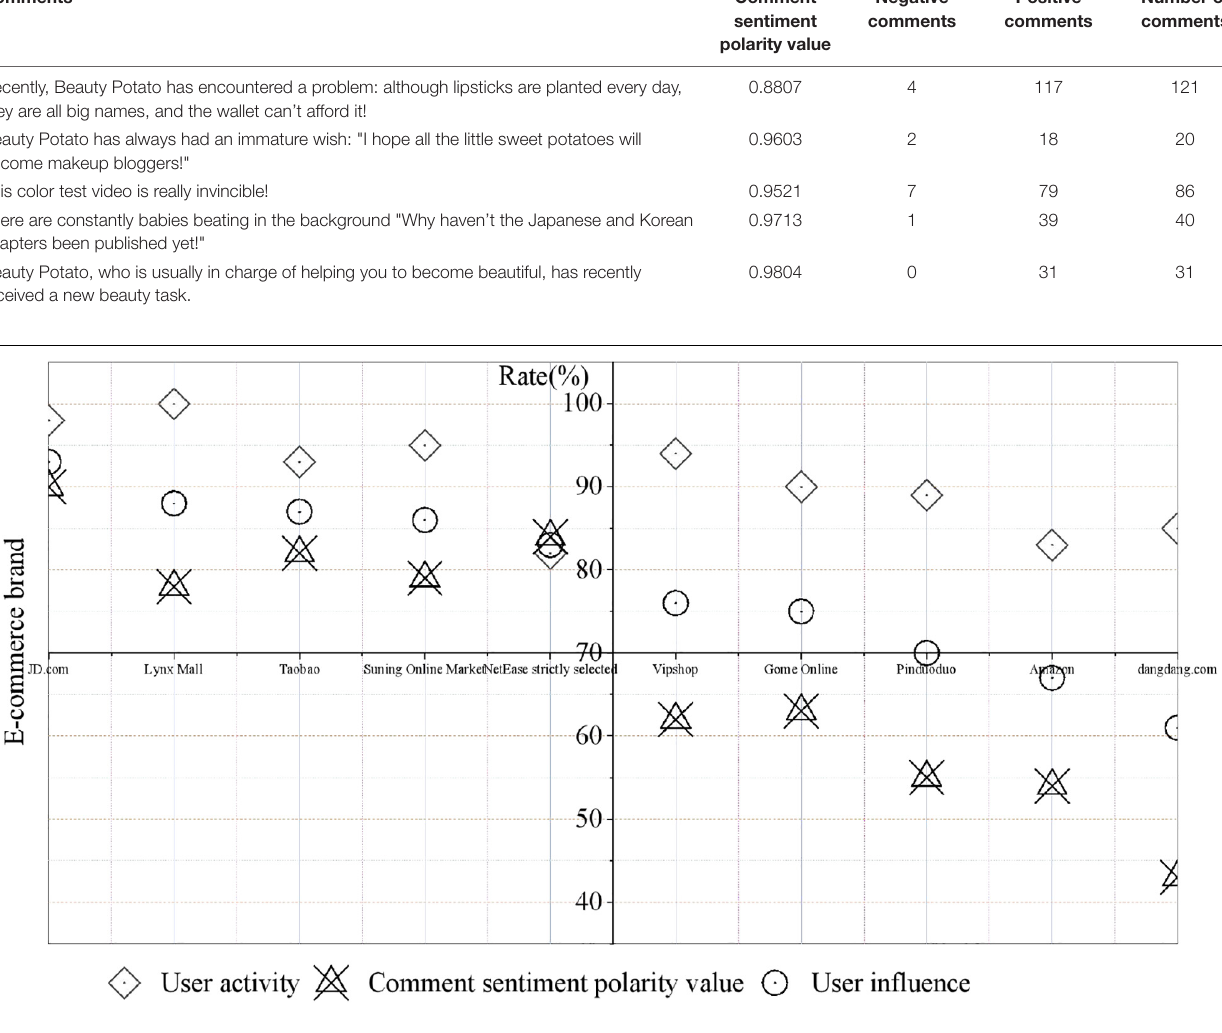
FIGURE 2 | User influence